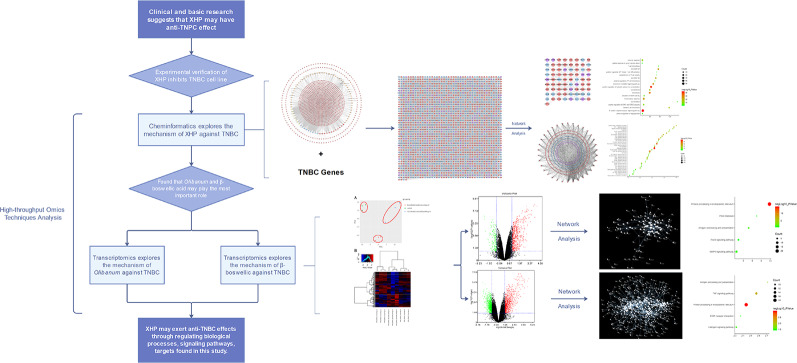
The process of this research.